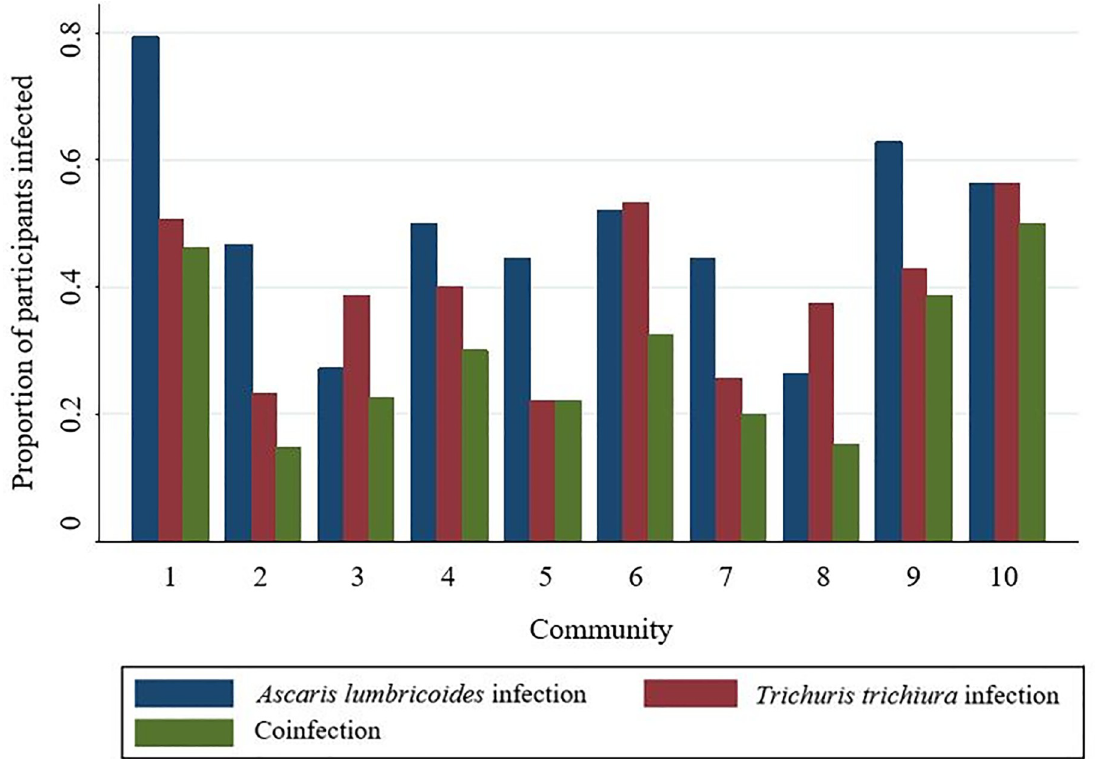
Fig 1. Infection prevalence rates. Proportion of participants by community infected with A . lumbricoides , T . trichiura , or coinfected with both species. See S1 Table for community descriptions. Communities are listed in order of median household style of life scores, which serves as an approximation of community market integration level. Community median style of life scores are presented from lowest to highest (i.e., community 1 has the lowest median score, while community 10 has the highest).